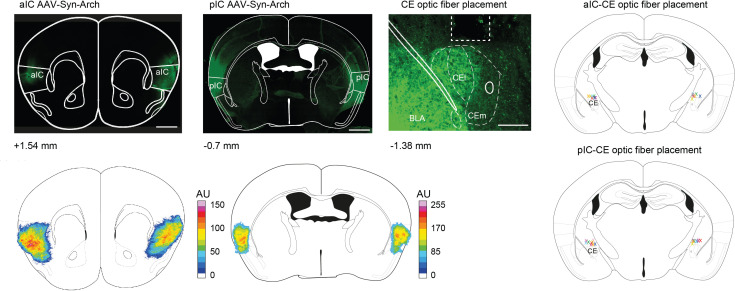
Histological assessment of optogenetic IC–CE manipulation cohorts.(top, left) Exemplary pictures of AAV-Syn-Arch injection sites in aIC and pIC (scalebar = 900 µm) and optic fiber placement above CE (scalebar = 100 µm). (bottom, left) Representation of the injection spread in aIC and pIC; heatmap corresponds to the fluorescence intensity. (right) Schematic placement of the optic fiber tip above CE marked with ‘x’.